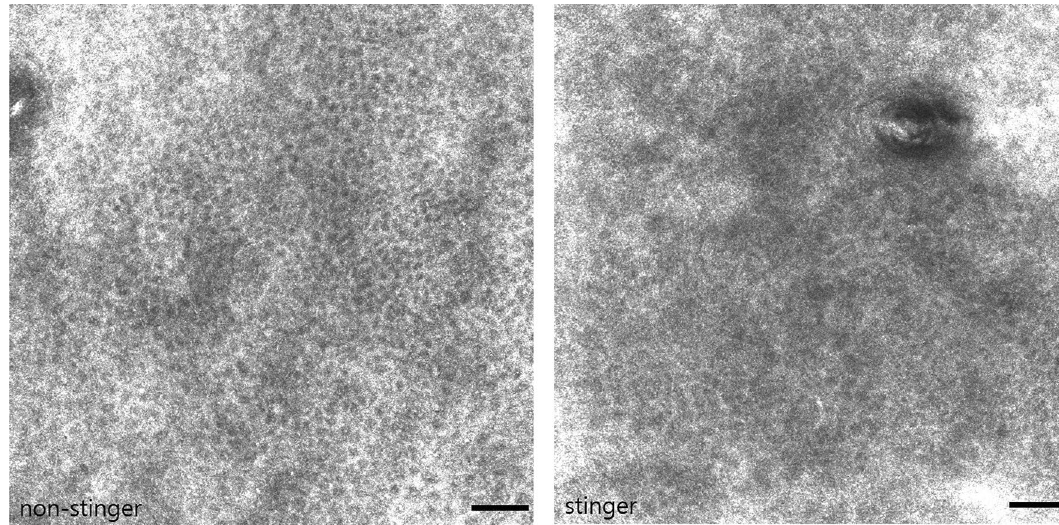
Figure 3. RCM images of the spinous layer on the face. A regular honeycomb pattern in a ‘non-stinger’ subject and irregular honeycomb pattern in a ‘stinger’ subject at 24 μm depth (Scale bar: 50 plementary Figure S3). Among the evaluation criteria, telangiectasia (‘stinger’: 2.24, ‘non-stinger’: 1.63) and dyschromia (‘stinger’: 2.71, ‘non-stinger’: 2.19) showed the most significant difference between the two groups.